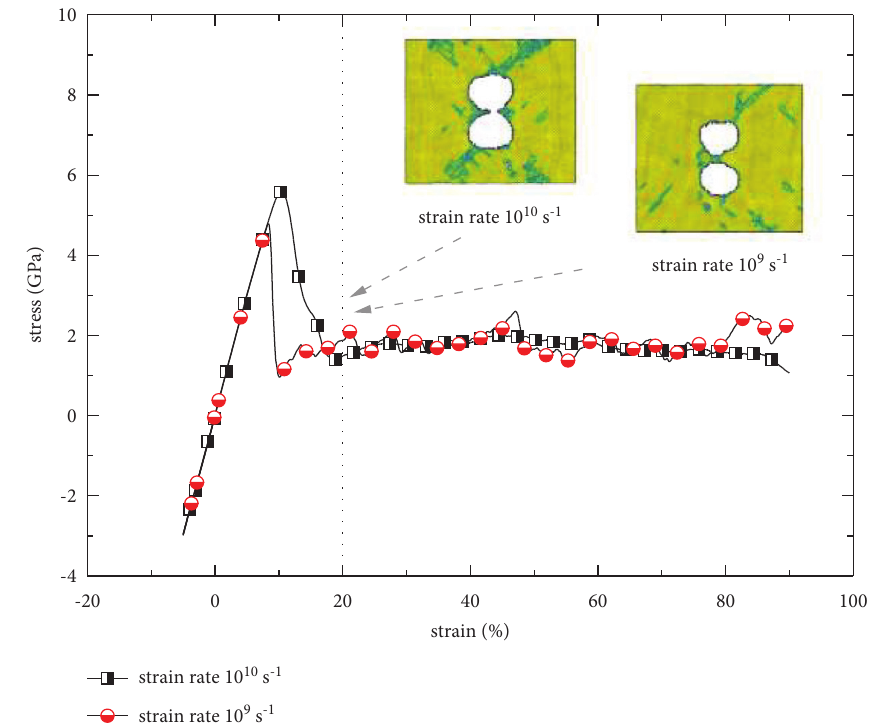
Figure 11: The stress-strain curve at different strain rates when the compressive strain is set to −